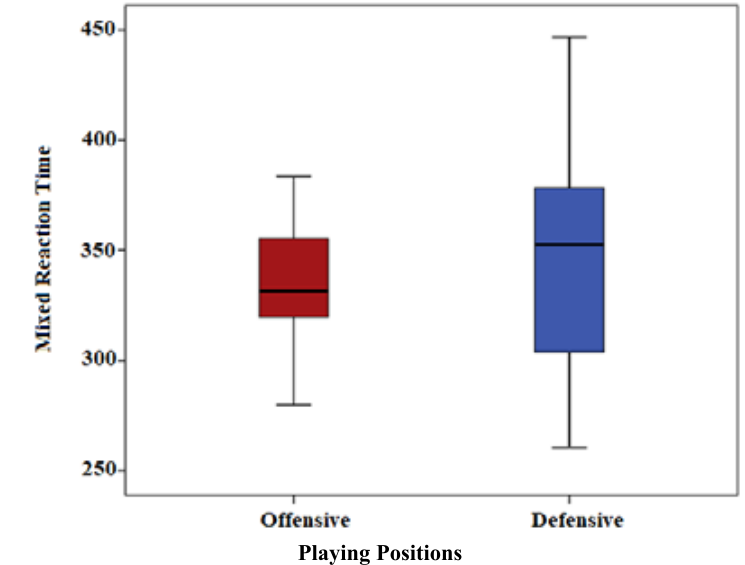
Playing Positions Figure 6. Comparison of Mixed Reaction Time (ms) of players according to playing positions